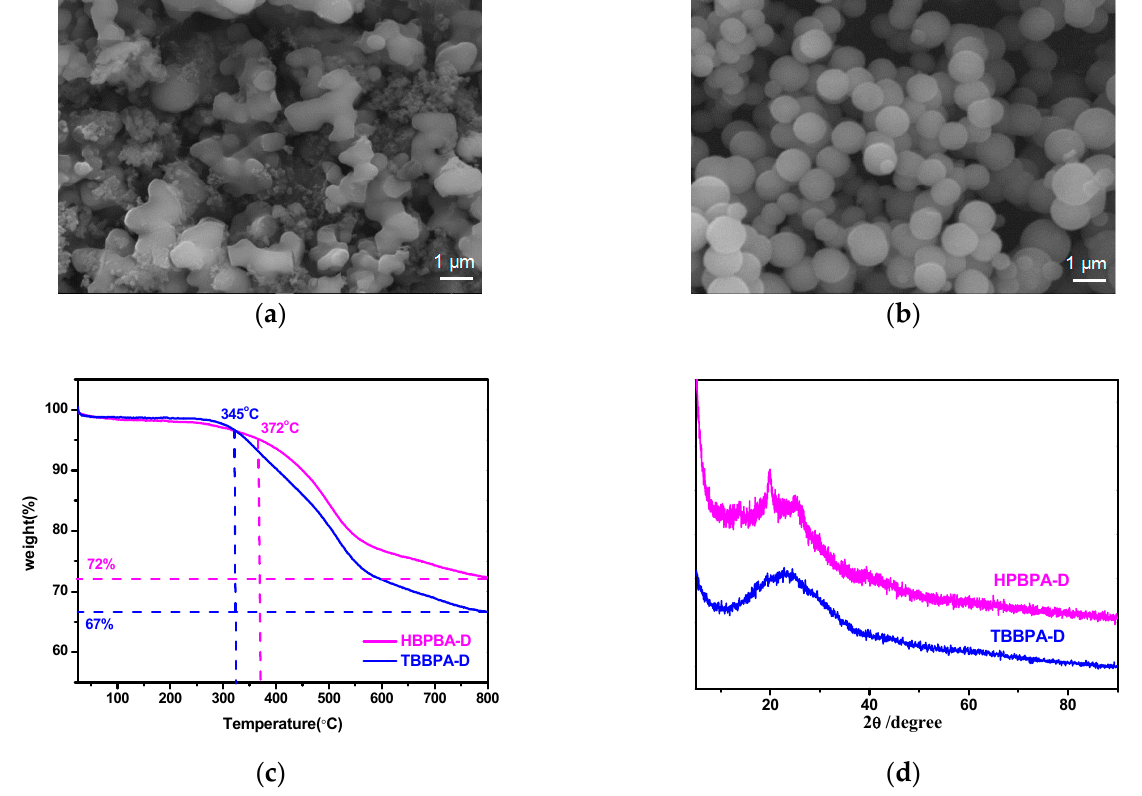
Figure 2. SEM images of ( a ) HBPBA-D and ( b ) TBBPA-D; ( c ) TGA plots of HBPBA-D and TBBPA-D; ( d ) XRD pattern of HBPBA-D and